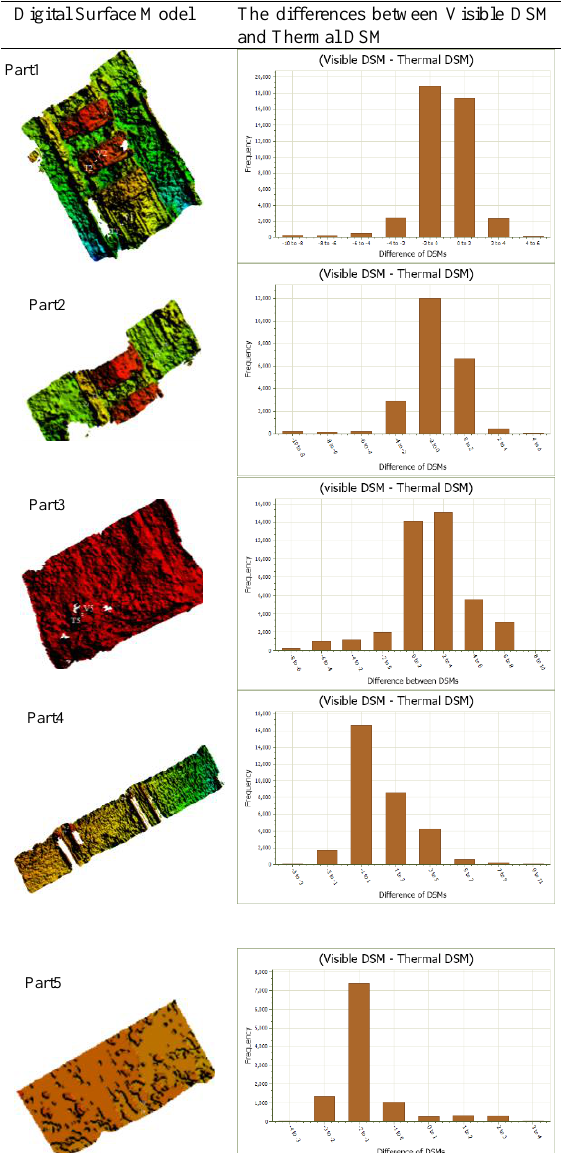
Figure 9. The comparison of the thermal DSM with visible